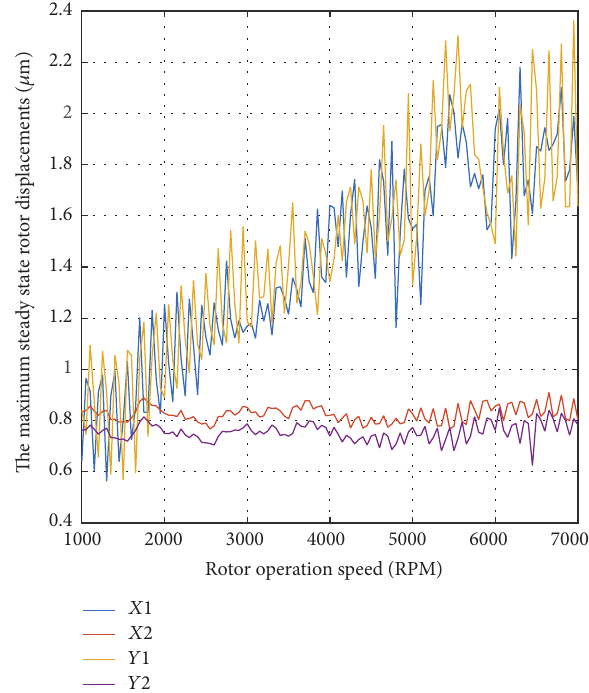
Figure 21: The maximum steady-state rotor displacements with ILC